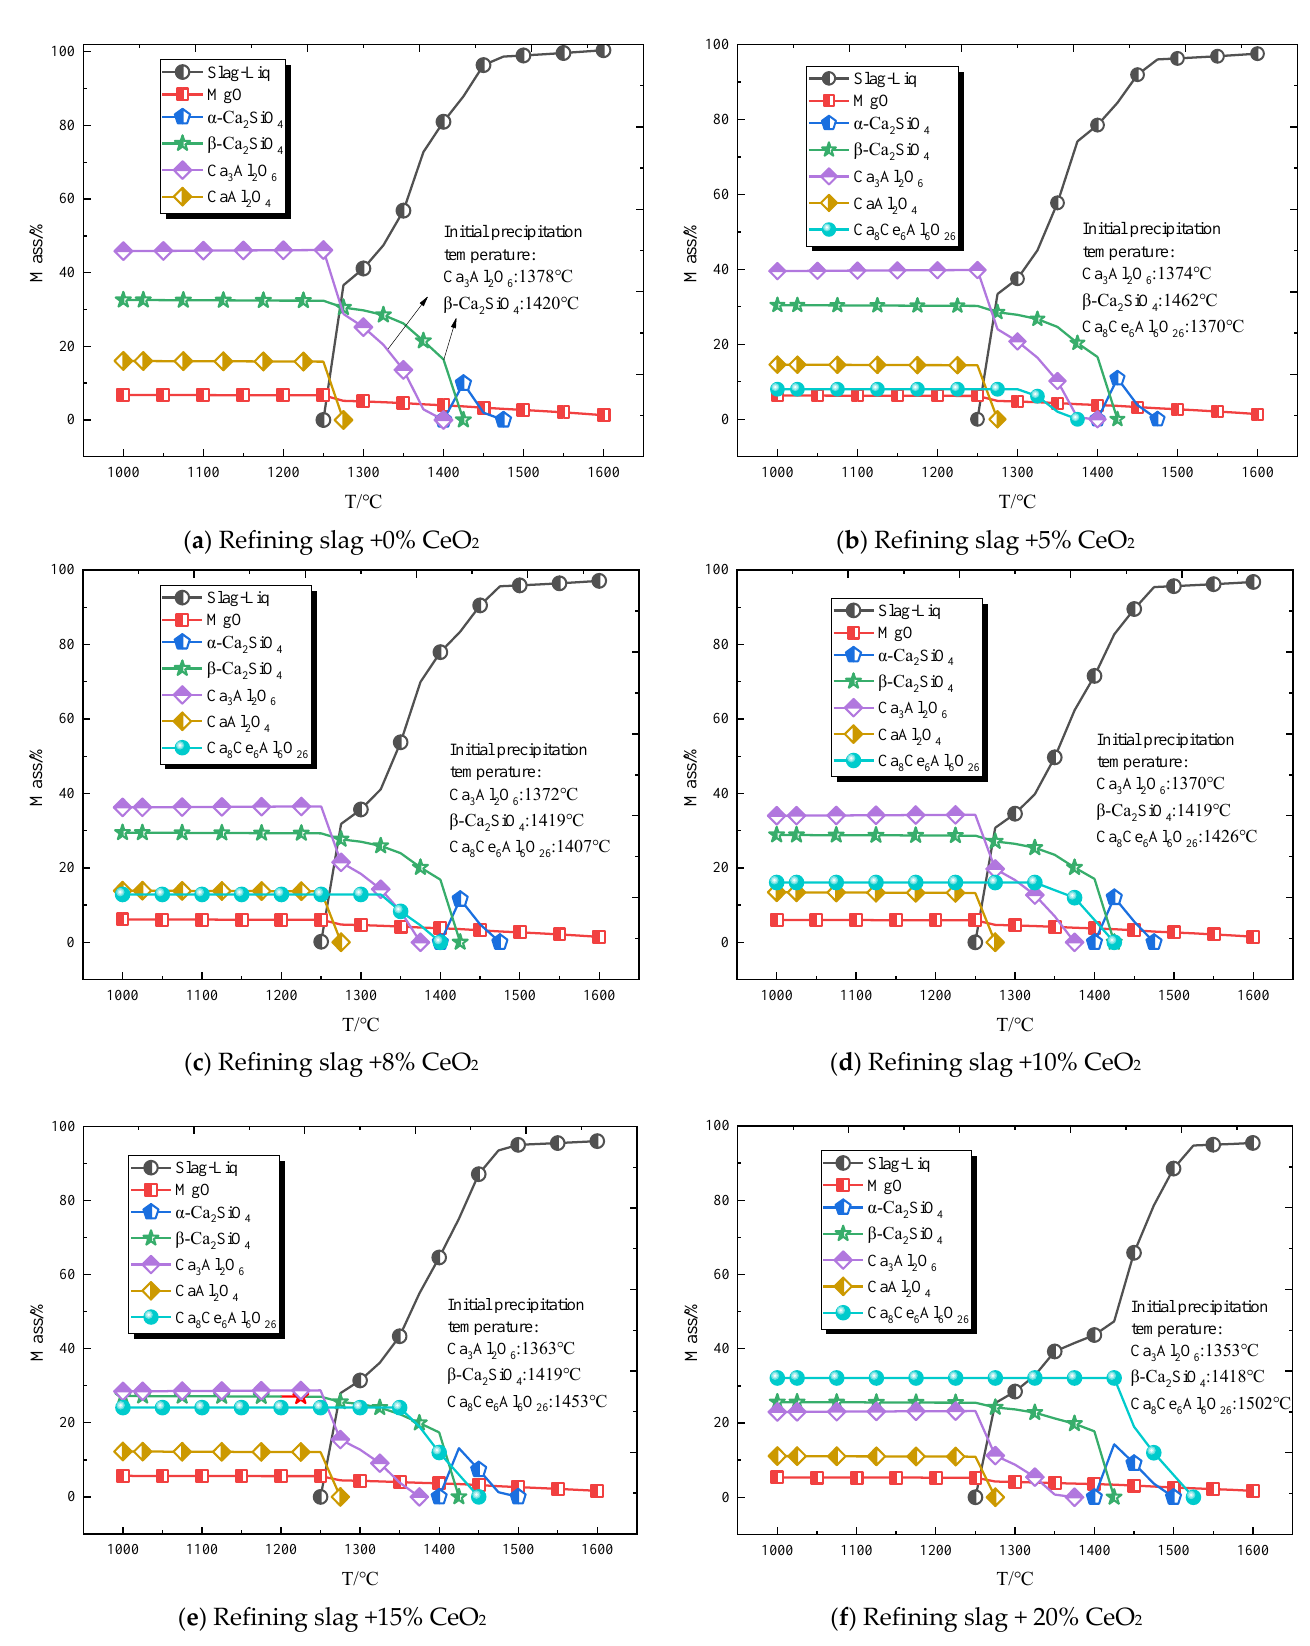
Figure 8. Equilibrium transformations of slag phases.